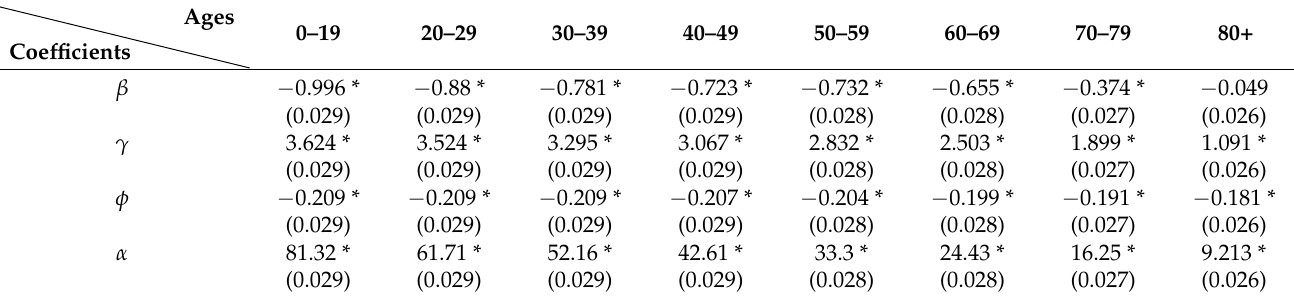
Table 2. Regression coefficients (with standard errors of means in parentheses) estimated from model constructions of difference-in-differences comparing the life expectancies of Canadians and